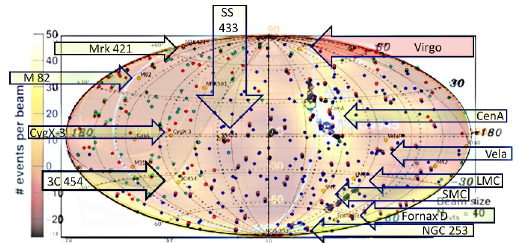
Figure 4: UHECR map in galactic coordinate with marked the main probable identified sources and the missing ones as Virgo. The role of 3C 454 may be relevant only if the narrow clustering will be more enhanced [15]. A 39 EeV anisotropy and a 20 EeV multiplet map is also